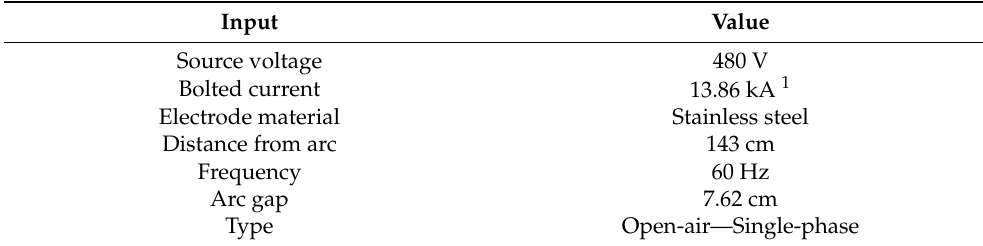
Table 4. Relation of input data for ArcPro simulation—Case study